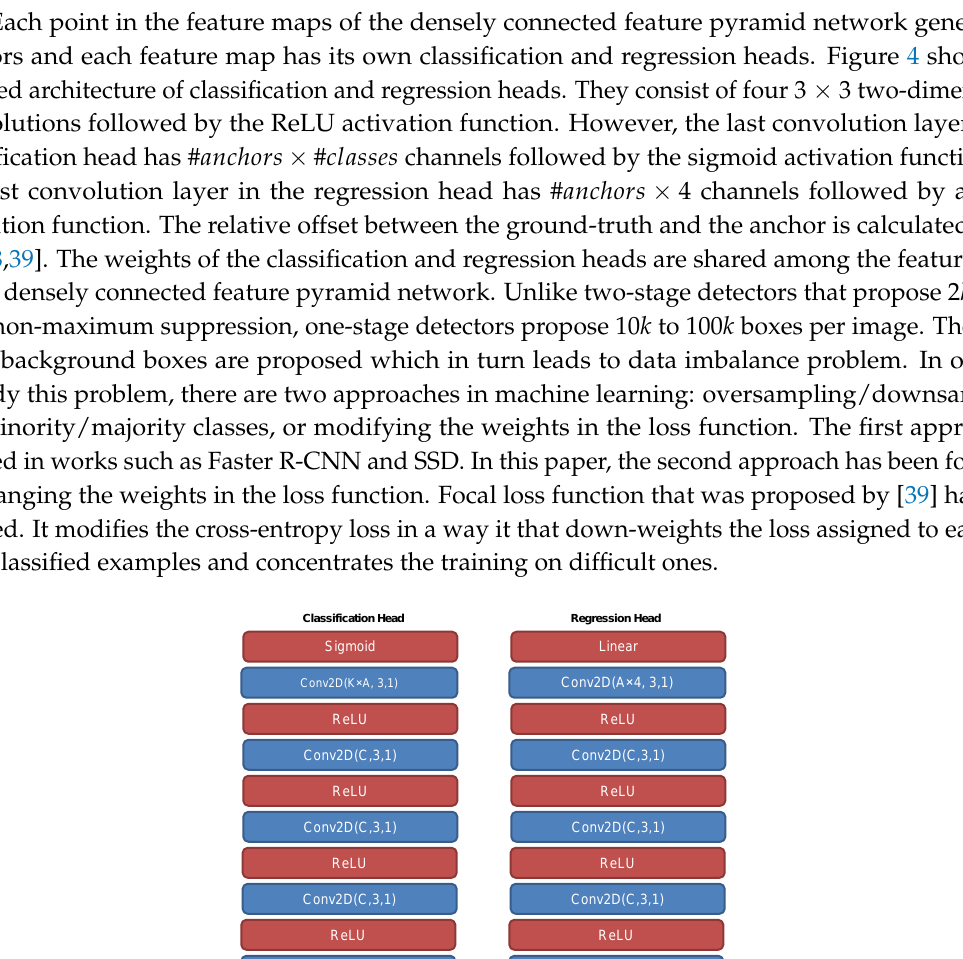
Figure 3. The architecture of the densely connected feature pyramid network.